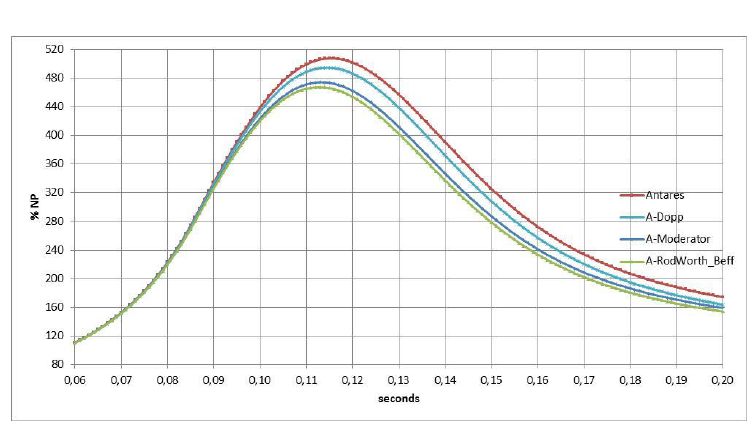
Figure 3: Rod Ejection with